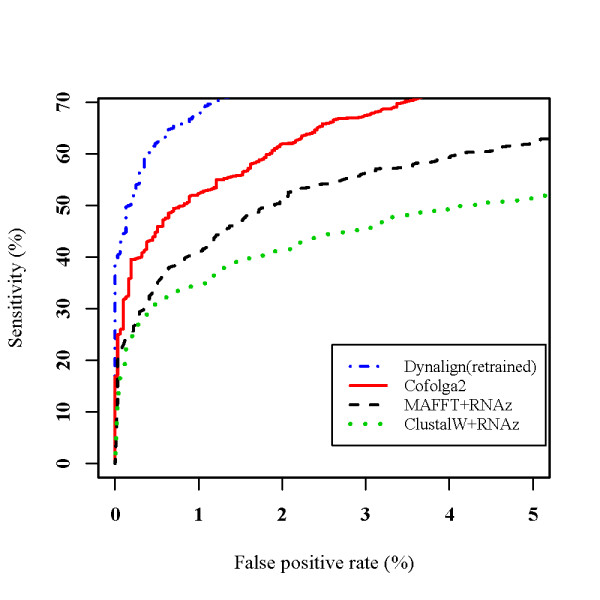
Comparison of ncRNA prediction performance. The ROC curves drawn for the alignments ≤ 50%id. The ROC curve obtained using Dynalign 4.3 with the SVM model re-trained in the present study is denoted by 'Dynalign(retrained)'.